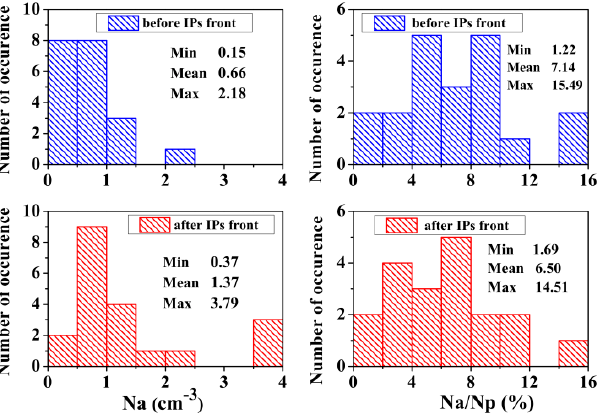
Figure 6. Statistical histograms of the absolute ( left ) and relative ( right ) He ++ ion density in undis- turbed and disturbed solar wind.